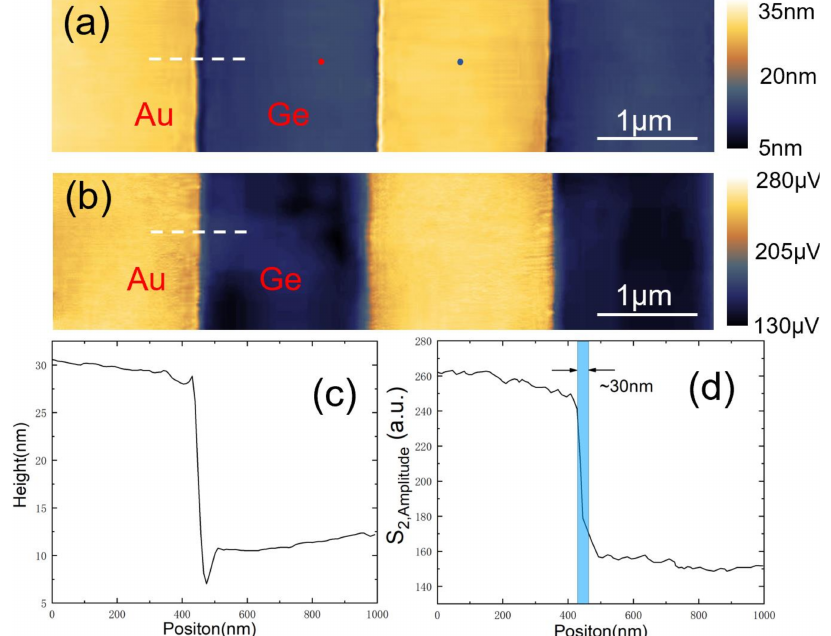
Figure 4. ( a ) AFM topography (the blue and red points are the positions of the AFM probe when the spectrum was collected in Figure 6) and ( b ) the second harmonic near-field amplitude image obtained simultaneously on a Ge-Au periodic grating sample with the reference mirror set to the ZPD position. ( c ) Represents a line scanning (white dashed line) averaged over 6 consecutive horizontal lines on the topography scan, while ( d ) represents the same location for the near-field line scanning, and a spatial resolution of ~30 nm is demonstrated.